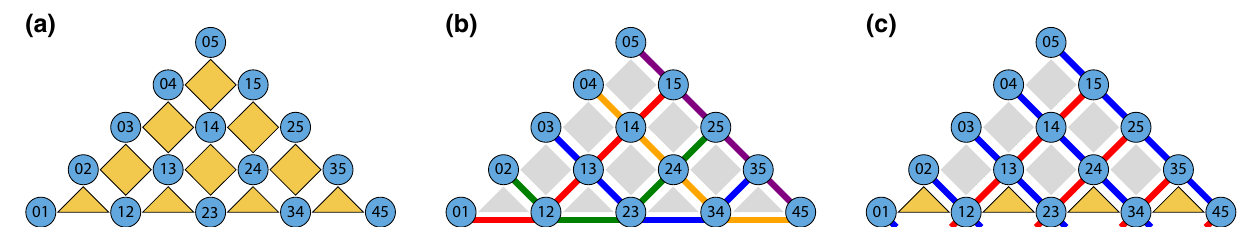
FIG. 2. An example of a parity-encoded complete graph with six spin variables. (a) All constraints are enforced explicitly via the constraint Hamiltonian. The driver Hamiltonian contains single-qubit ˆ σ x operators on all physical qubits. (b) The colored lines denote sets of qubits, each of which can be flipped simultaneously without leaving the constraint-fulfilling subspace (constraint-preserving driver lines). All constraints are implicitly enforced via the driver Hamiltonian and no energy penalty for constraints is needed. (c) Only the bottom-most row of three-body constraints is enforced explicitly, while the others are satisfied implicitly due to the restriction of dynamics via the driver Hamiltonian. In this setting, all driver lines of the same color can be implemented in